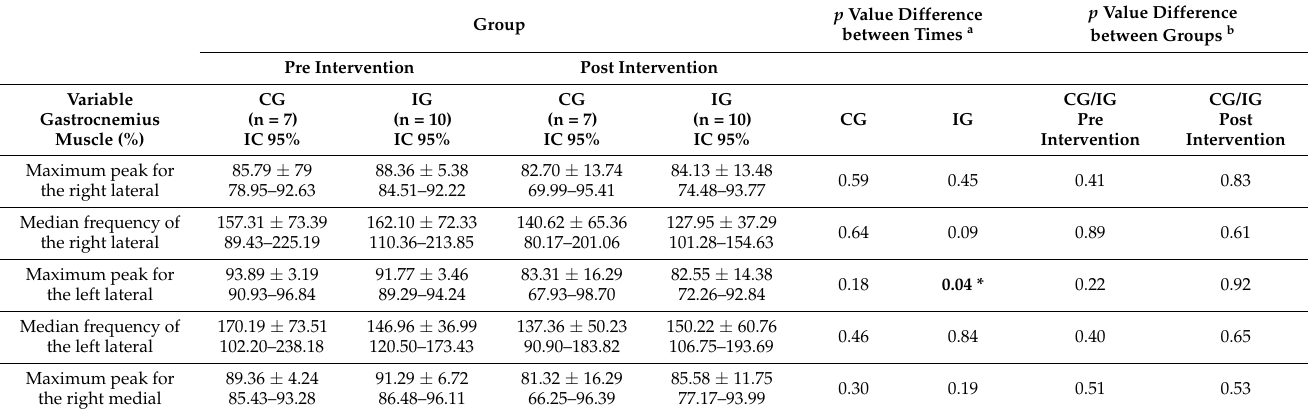
Table 3. Mean values, standard deviation and confidence interval in the comparison of GC and IG for electromyography variables in isotonic